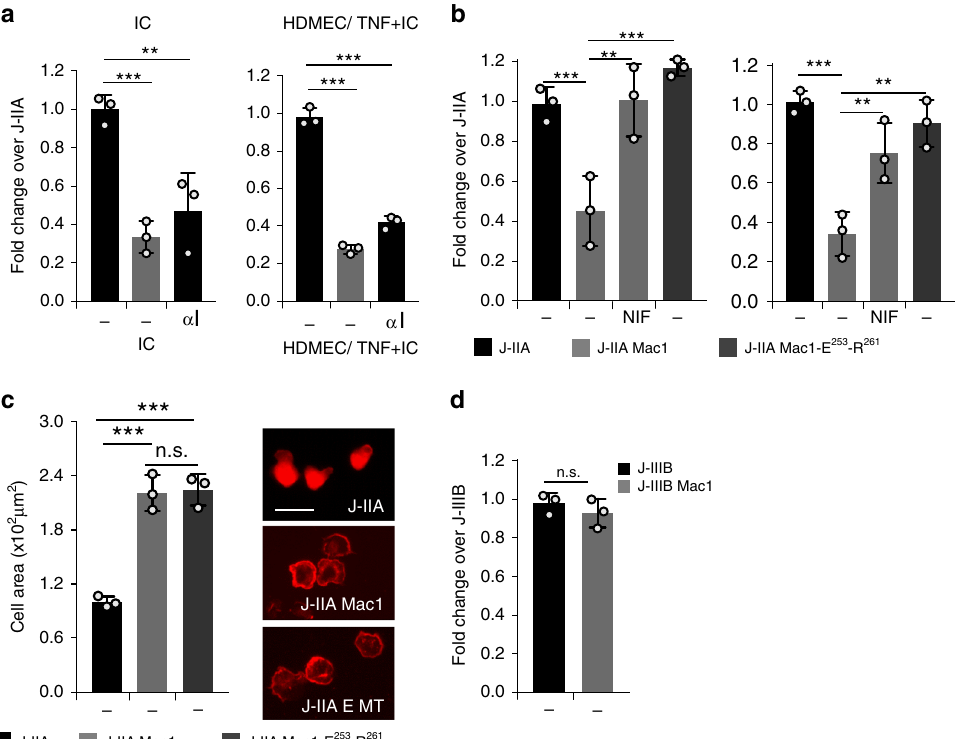
Fig. 3 Mac-1 ’ s α I-domain reduces Fc γ RIIA binding to ICs, but does not affect cell spreading or Fc γ RIIIB binding to ICs. Jurkat cells expressing either Fc γ RIIA or Fc γ RIIA and Mac-1 with or without pretreatment with recombinant α I-domain (100 μ g/ml) for 30 min at 37 °C ( a ), without or with pretreatment with recombinant NIF (10 nM) ( b ), or J-IIA cells expressing Mac-1-E 253 -R 261 mutant ( b ) were perfused at 1 dyne/cm 2 over IC-coated coverslips ( a and b , left panels) or TNF activated and IC coated HDMEC on coverslips ( a and b , right panels). The number of adherent Jurkats was assessed and averaged. Data are represented as fold change compared to J-IIA cells of an average of 3 experiments ± SEM. c Indicated Jurkat cell lines were seeded onto immobilized ICs on coverslips for 30 min under static conditions. Coverslips were fi xed, permeabilized, and stained with Alexa 568 phalloidin to visualize the actin cytoskeleton. Bar graphs represent average adherent cell area and representative images are shown. Data is presented as average ± SEM of n = 3. d Jurkat cells expressing Fc γ RIIIB without (J-IIIB) or with Mac-1 (J-IIIB Mac1) were perfused over coverslip immobilized ICs at 1 dyne/cm 2 and the number of adherent cells were determined. Data are represented as fold change compared to J-IIIB. Data is average of 3 experiments ± SEM ** p < 0.01, *** p <